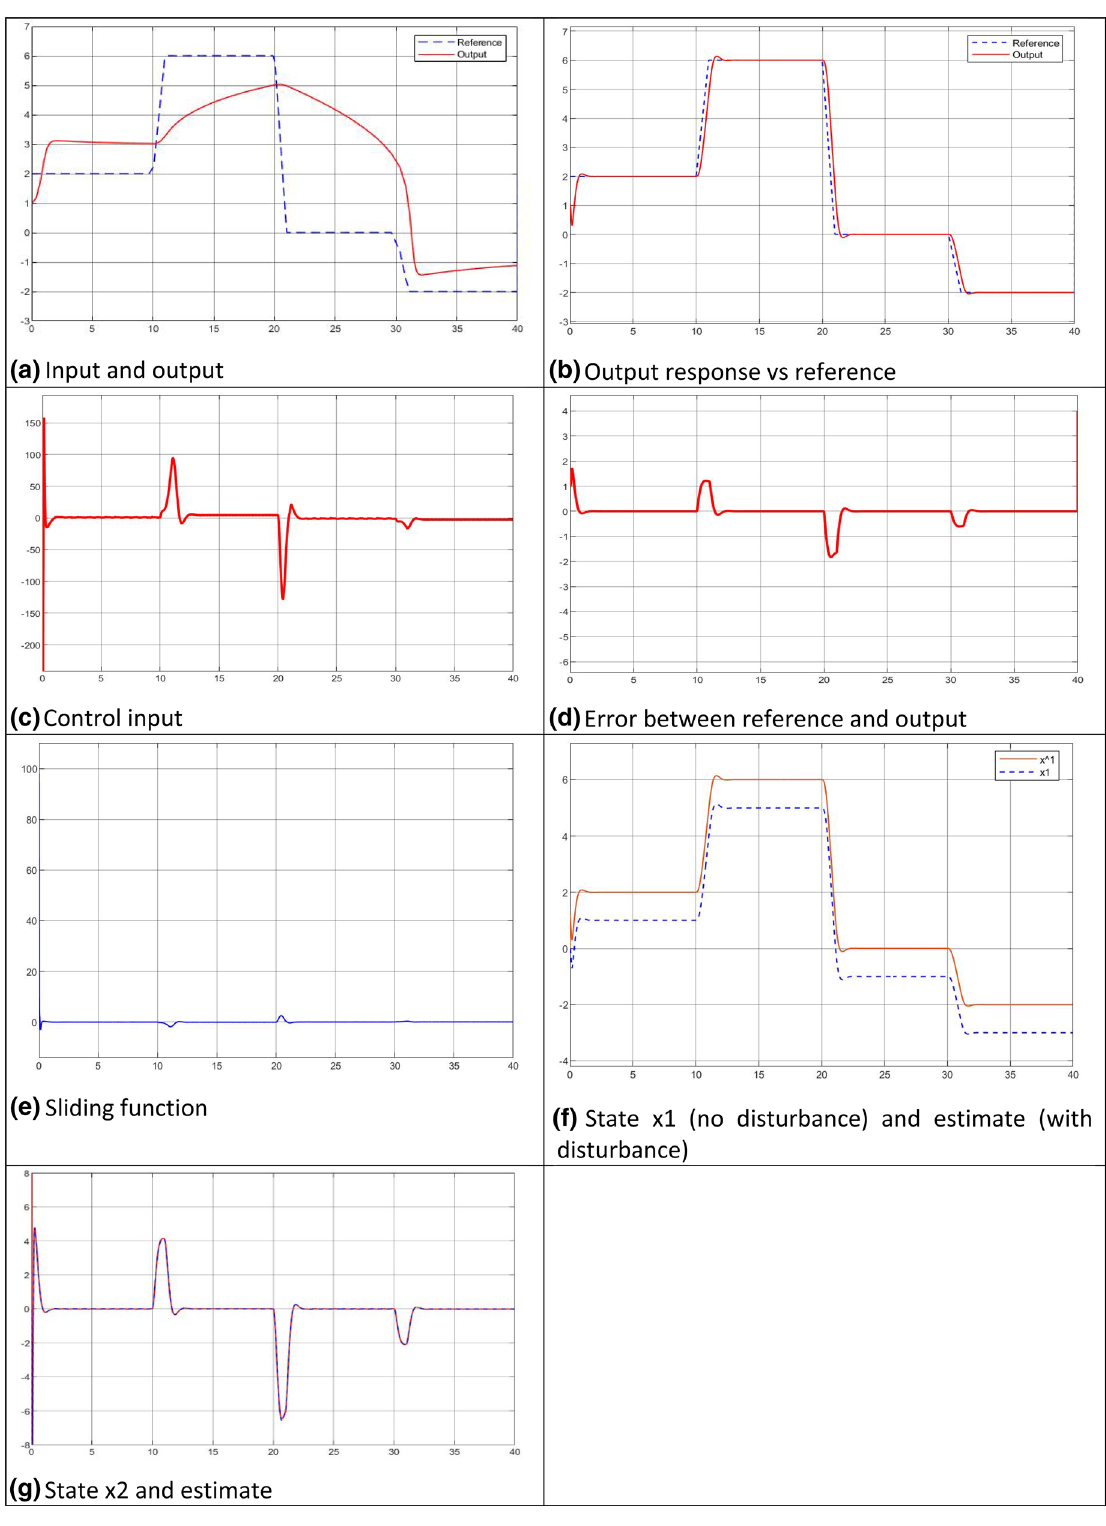
Figure 7. Case 2—simulated